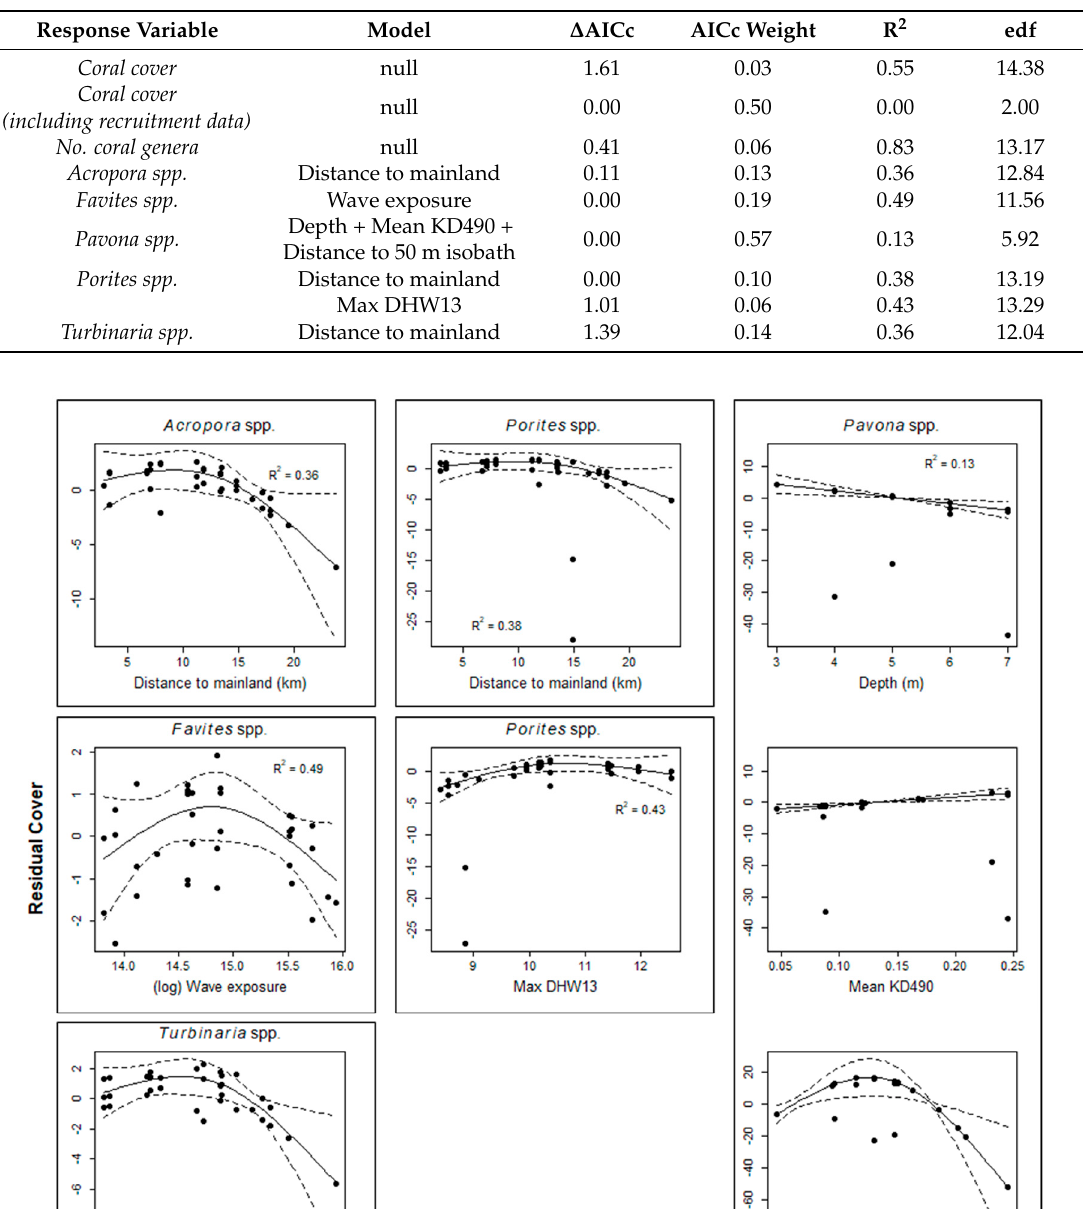
Table 2. Best generalised additive mixed models (GAMMs) for predicting coral cover, diversity and most abundant coral genera in the Dampier Archipelago, Western Australia. edf = estimated degrees of freedom. All models within two units of the lowest AICc value are reported in Table S2.